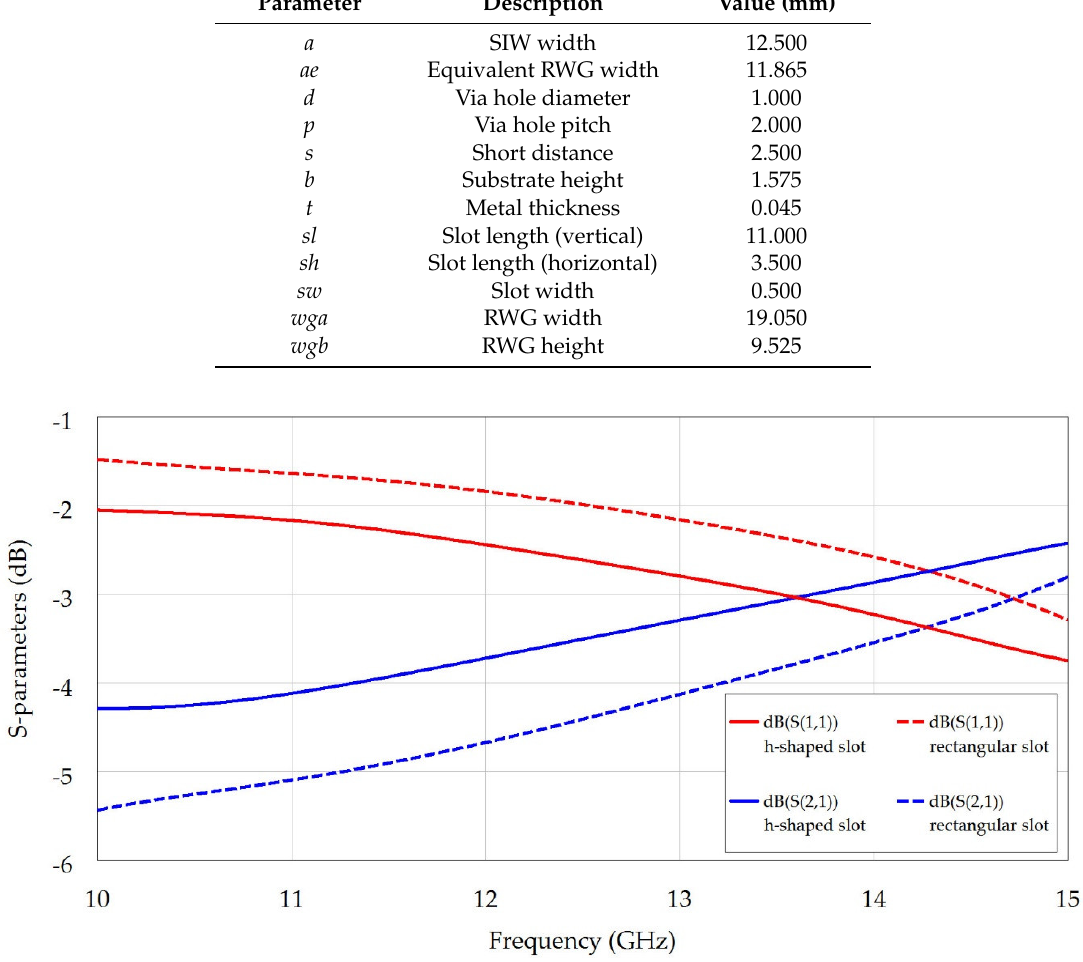
Table 1. RWG-to-SIW transition geometrical parameters.